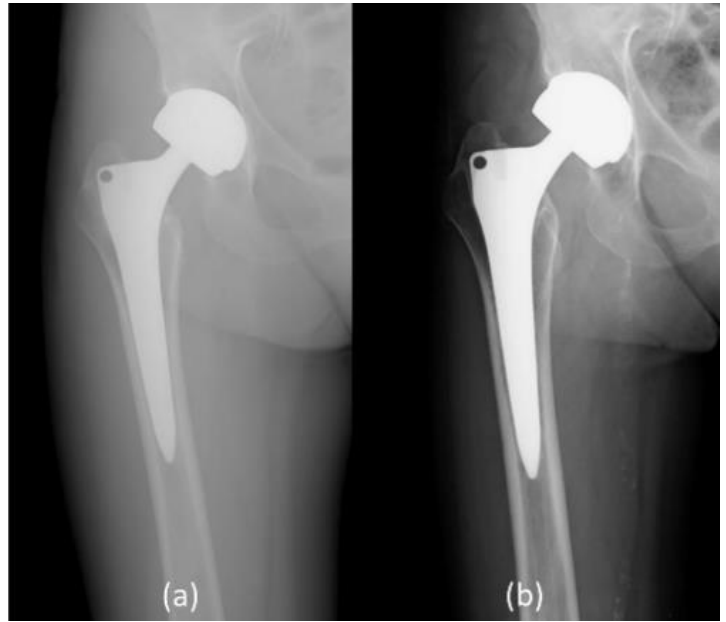
Figure 3. F.A., 81-year-old female, Metal-on-Metal Total Hip arthroplasty for primary arthrosis, right hip X-ray. ( a ) Post-operative follow-up, one month ( b ) Post-operative follow-up, 7 years (24 months after recruitment).